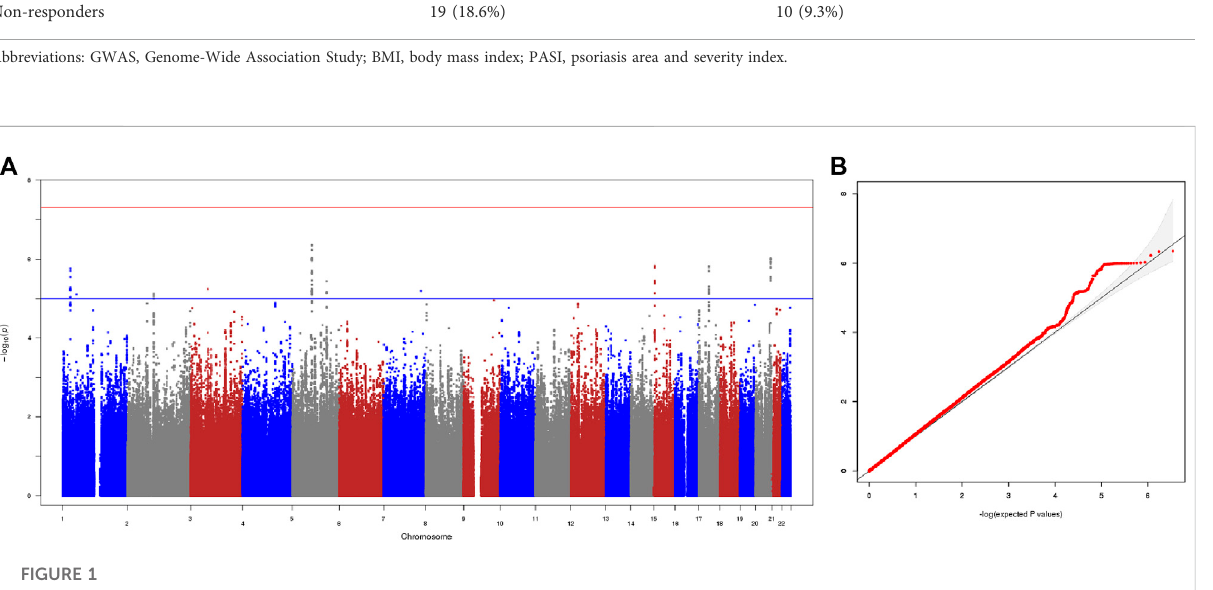
Psoriasis duration, years, mean ± s.d